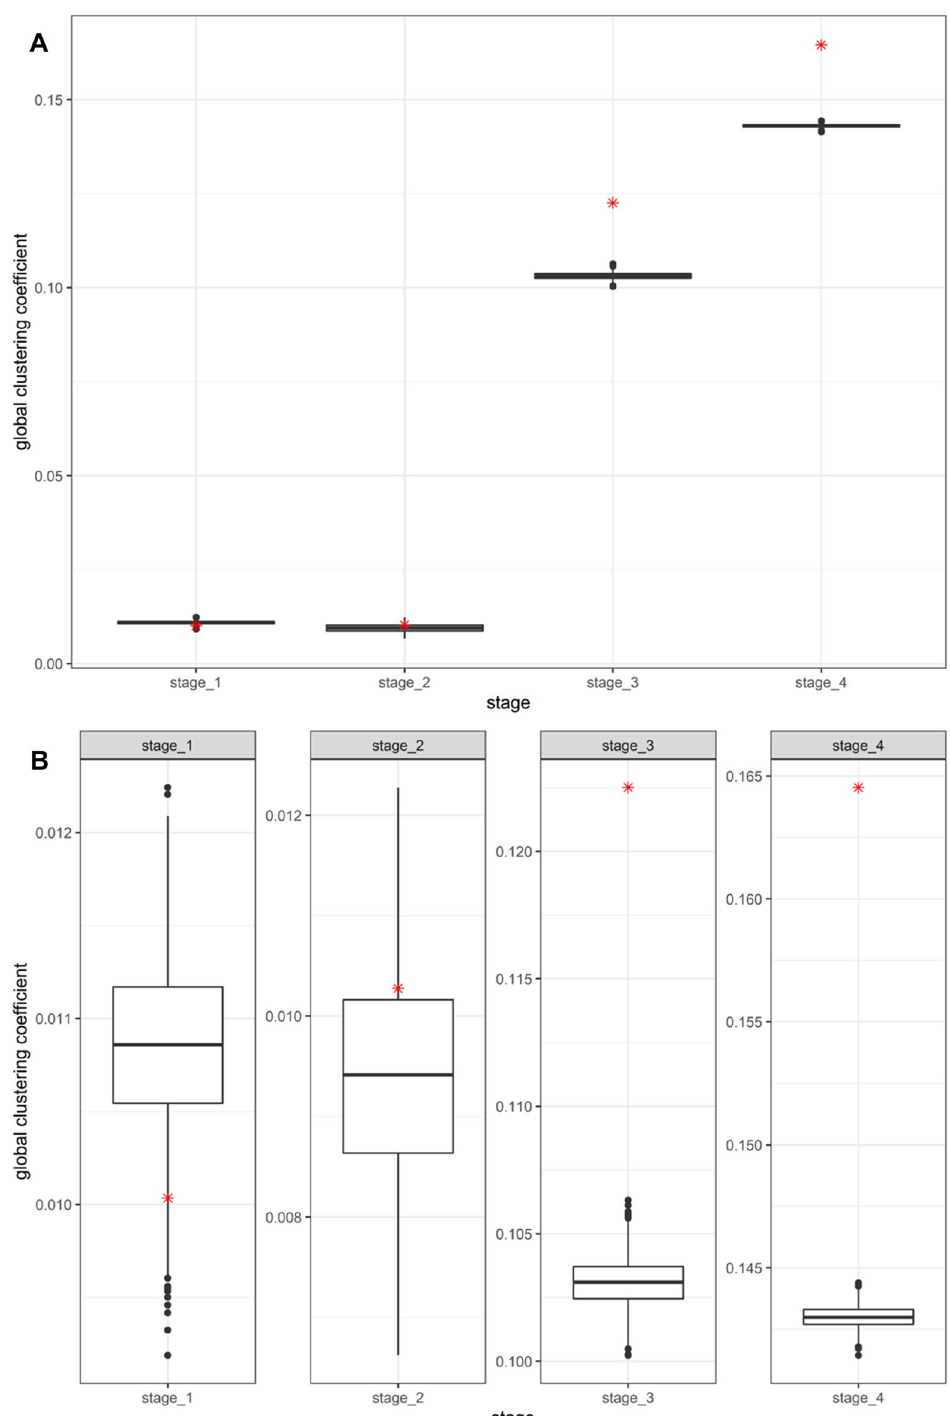
Figure 1. The distributions of global clustering coefficients and observed